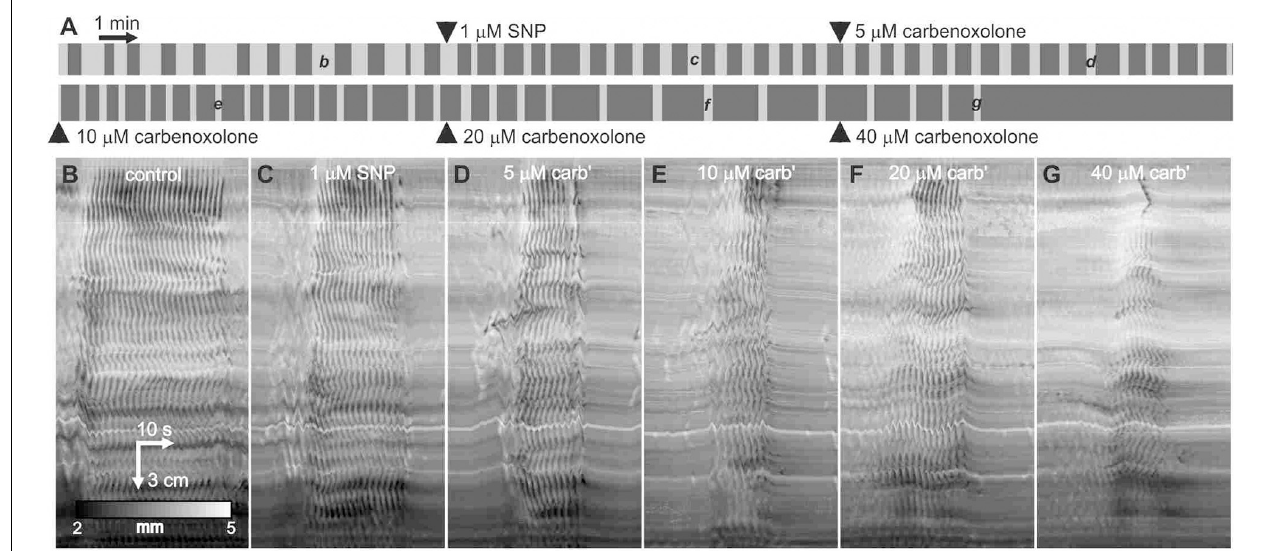
FIGURE 8 | Effect of carbenoxolone on clusters and gaps in the presence of SNP. (A) Telegraph image of DMaps from a single intestine showing the effect of SNP followed by the addition of increasing concentrations of carbenoxolone. Each image is half an hour long and drugs were added at 10-min intervals. (B–G) Example clusters from the same intestine as indicated in panel (A) . All shown at the same